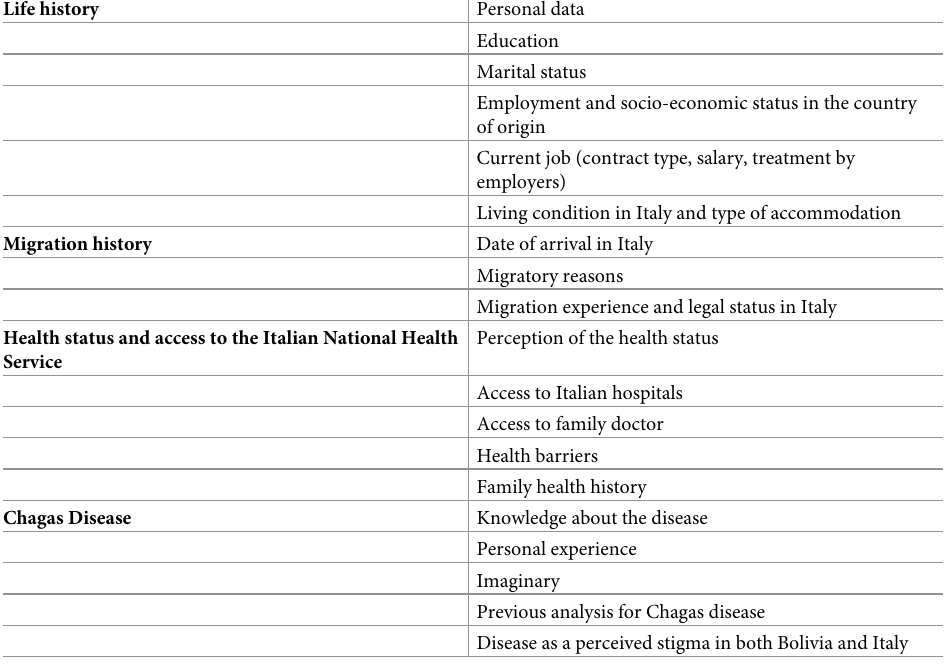
Table 1. Items included in the anthropological